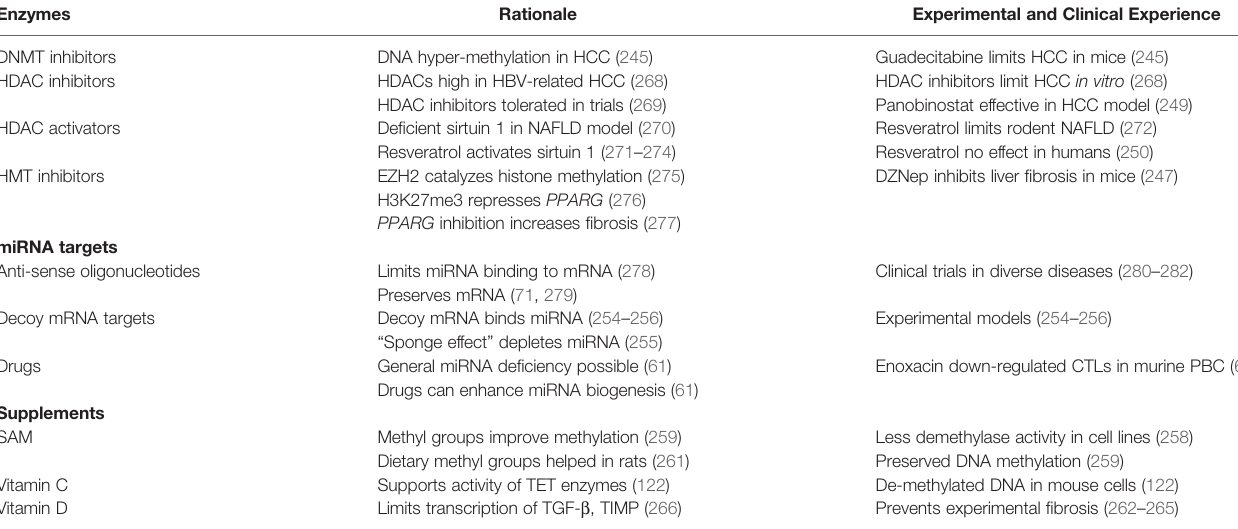
TABLE 5 | Therapeutic manipulations of epigenome. Enzymes